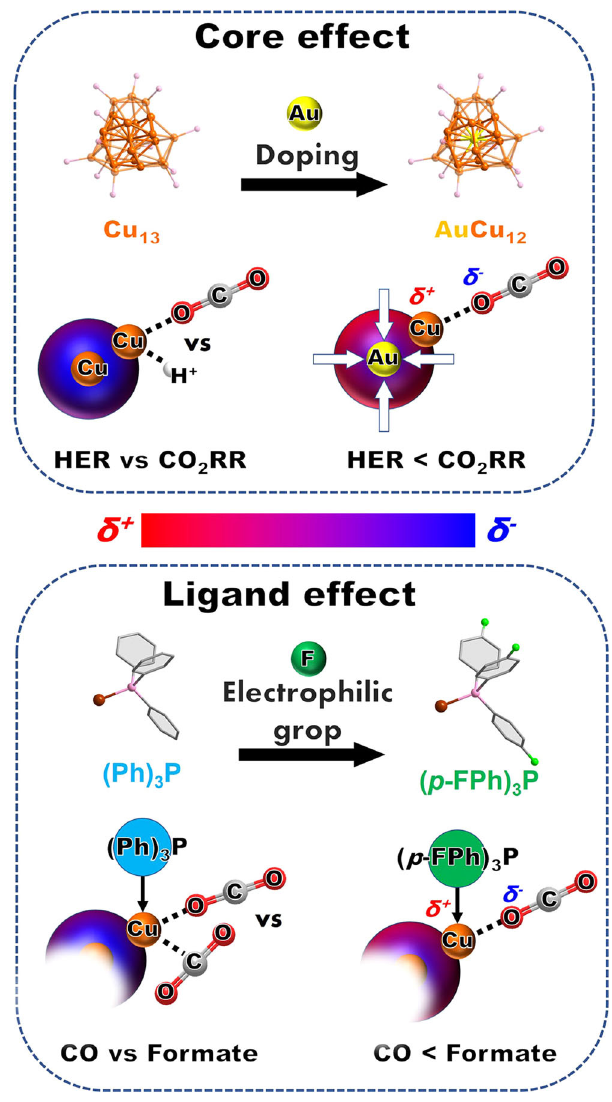
Fig. 4 The scheme of electron distribution modulating on NCs by